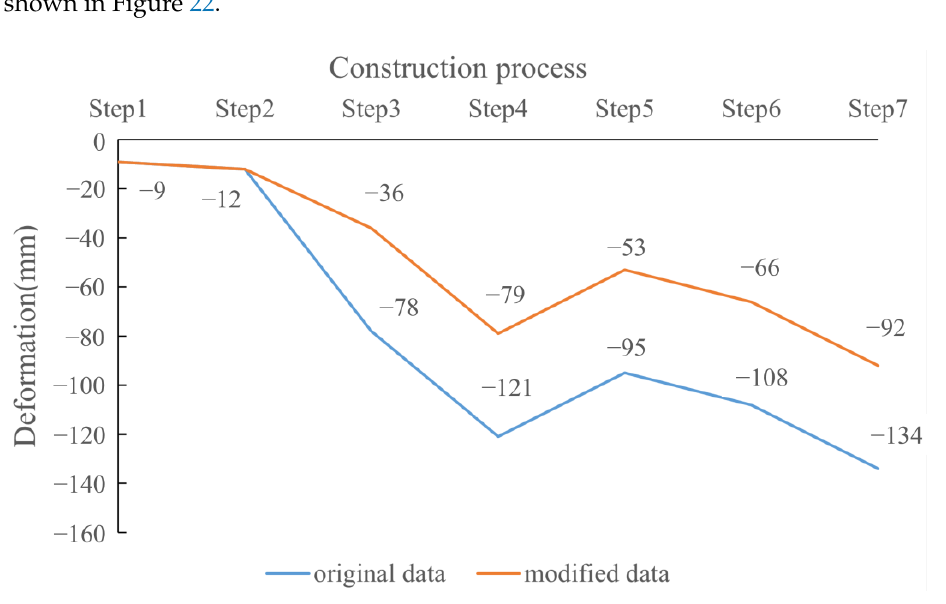
Figure 22. Modified deformation of Pier P30 considering support friction.